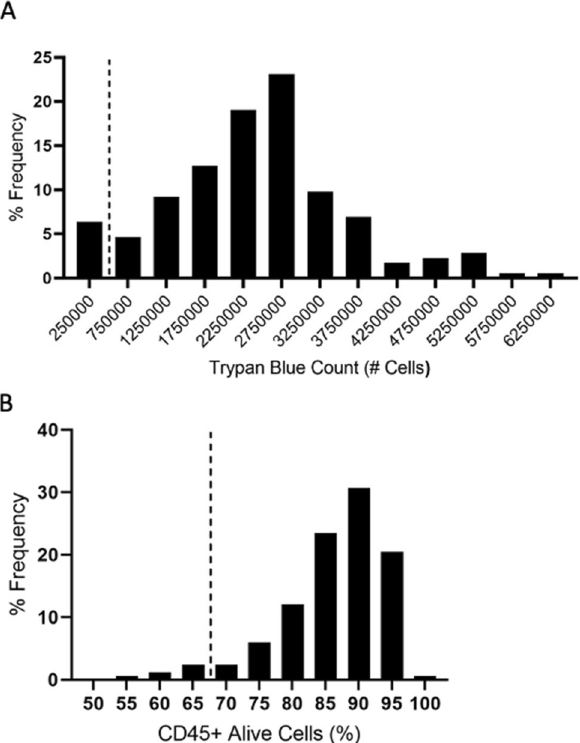
(Table 2). The viability of banked PBMCs by site is shown in Table 3. Early in sample collection, the transportation method from Site 1 to the processing site was changed from samples being transported on ice, to being trans- ported at room temperature. This change led to an 32.1% increase in sample viability. Fisher’s exact test showed that samples processed on site had a significantly higher proportion of quality control passes than sites where samples were transported prior to processing ( p < 0.01). The mean time (± SE) spent in the freezer before the viability assessment was 286.1 ± 10.6 days. Samples that passed quality control spent 276.0 ± 11.1 days frozen, whereas samples that failed quality control spent 321.0 ± 27.3 days frozen. The difference in the number of days and months spent in the freezer between samples that passed or failed quality control was not significant ( p = 0.11).Complete blood count (CBC) reports detailing